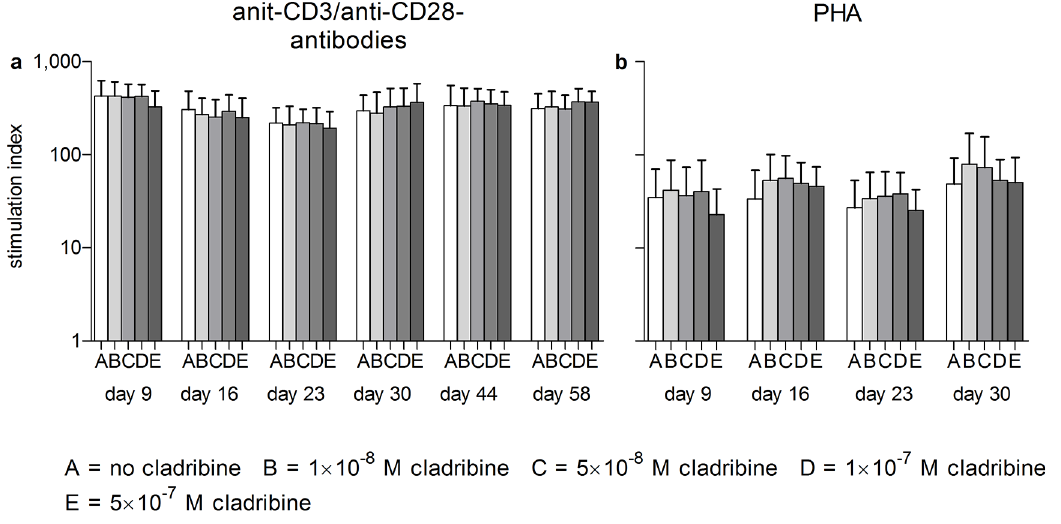
Fig 3. In vitro effects of initial cladribine treatment on the proliferation of PBMCs stimulated at Days 9, 16, 23, 30, 44 and 58 after transfer into cladribine-free medium PBMCs were initially incubated in the absence or presence of cladribine (1×10 − 8 M to 5×10 − 7 M) for 72 h. Cells were washed three times and then transferred into cladribine-free medium. Cells were restimulated with anti-CD3/anti-CD28 antibodies (a, n = 5) or PHA (b, n = 4) for 48h at Days 9, 16, 23, 30, 44 and 58; proliferation was determined by the incorporation of tritiated thymidine. Stimulation indices were defined as the ratios of the counts per minute of stimulated samples to unstimulated and untreated samples. Data are depicted as mean + standard deviation (SD).